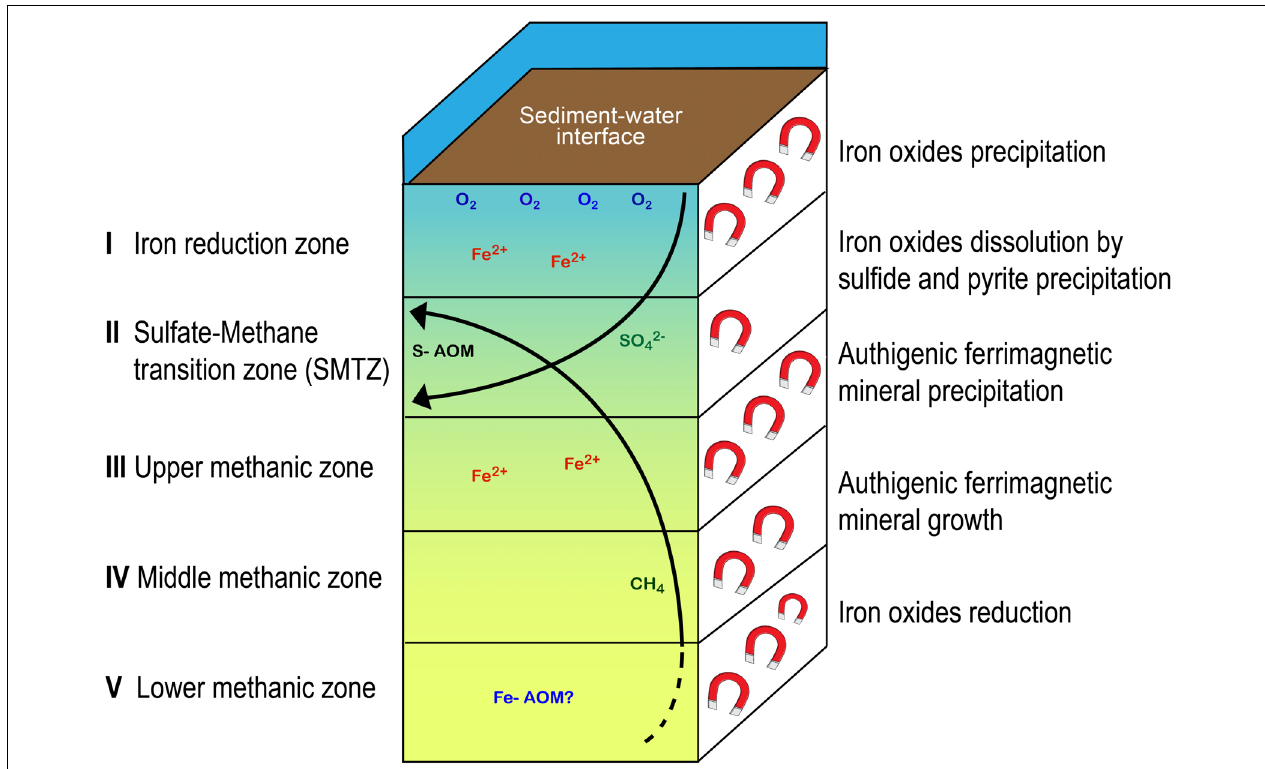
FIGURE 8 | Schematic illustration with a general scheme of the five diagenetic zones, the microbial processes and the resulting magnetic changes in the sedimentary